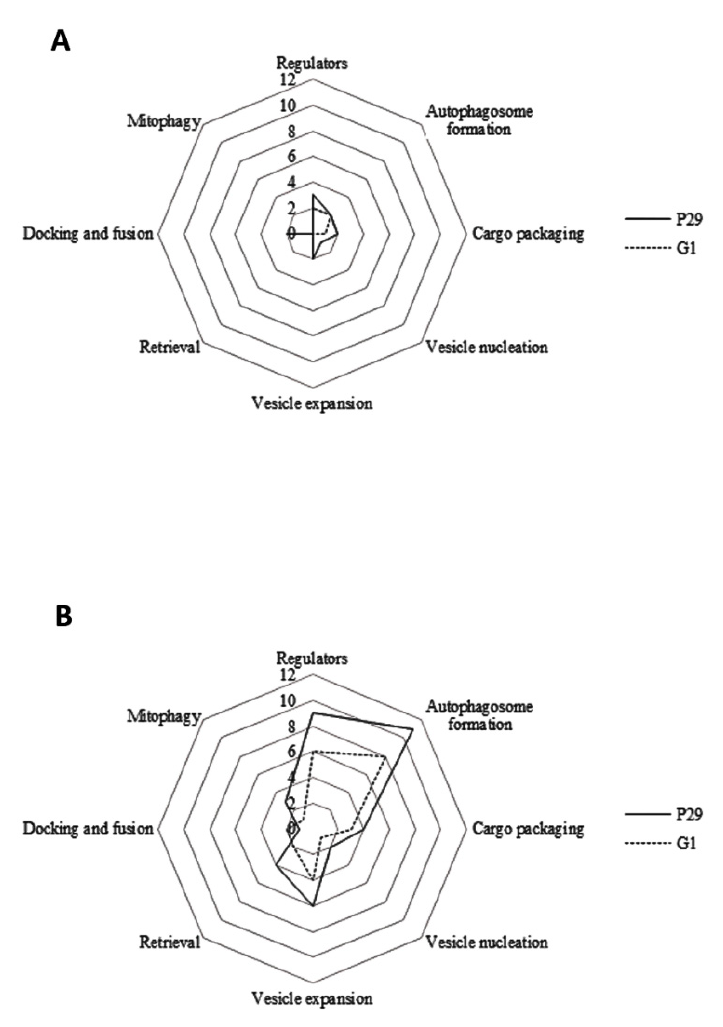
Figure 1. Total number of autophagy-related proteins required for each process step identified in S. cerevisiae P29 and G1 under ( A ) PC (endogenous CO 2 overpressure condition) and ( B ) NPC (non-pressure condition).